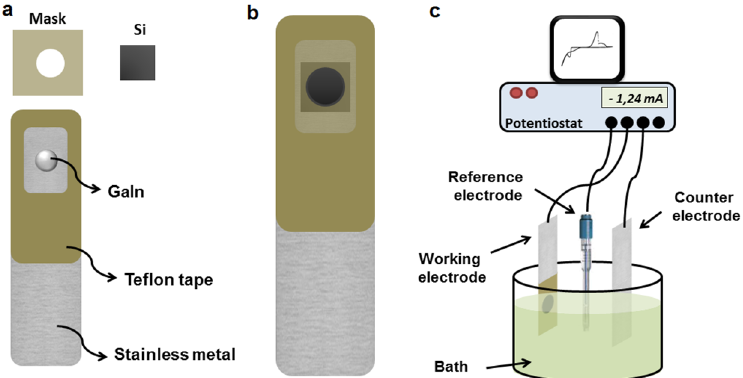
Figure 1. ( a ) Components involved for mounting the working electrode. Teflon tape is used to prevent the contact between the stainless metal and the electrolyte. ( b ) Complete working electrode assembly and ( c ) Representation of the electrochemical cell.